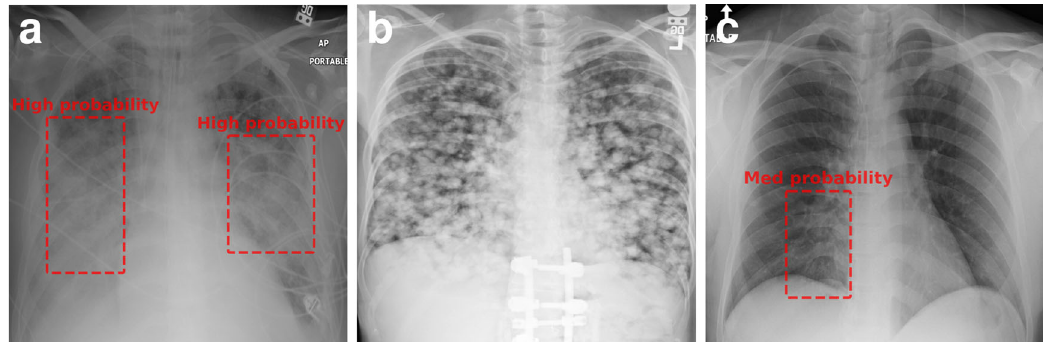
Fig. 5 Chest X-ray images selected from NoisyCXR dataset, which do not contain “ pneumonia" label in the NIH dataset 3 . a Correctly identi fi ed noise case with pneumonia-like opacities shown with bounding boxes. b Wrongly fl agged sample with a correct label; here the model confuses lung nodules with pneumonia-like opacities. c A dif fi cult case with subtle abnormality where radiologists indicated medium-con fi dence in their diagnosis as shown by the highlighted region (RSNA study 9 ).